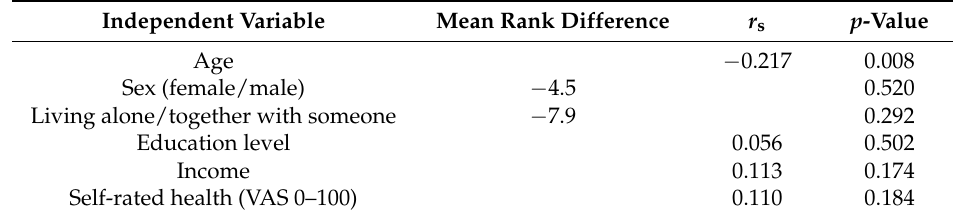
Table 2. Associations between PIADS total score for eHealth service illustrations in present and respondents’ profile variables ( n =